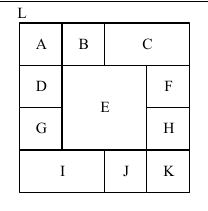
Figure 4. Representation of pattern’s structure.